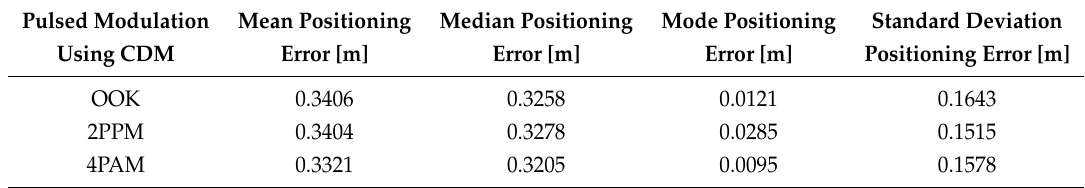
Table 5. Coarse Phase Positioning Performance for Pulsed Modulations using Code Division Multiplexing.